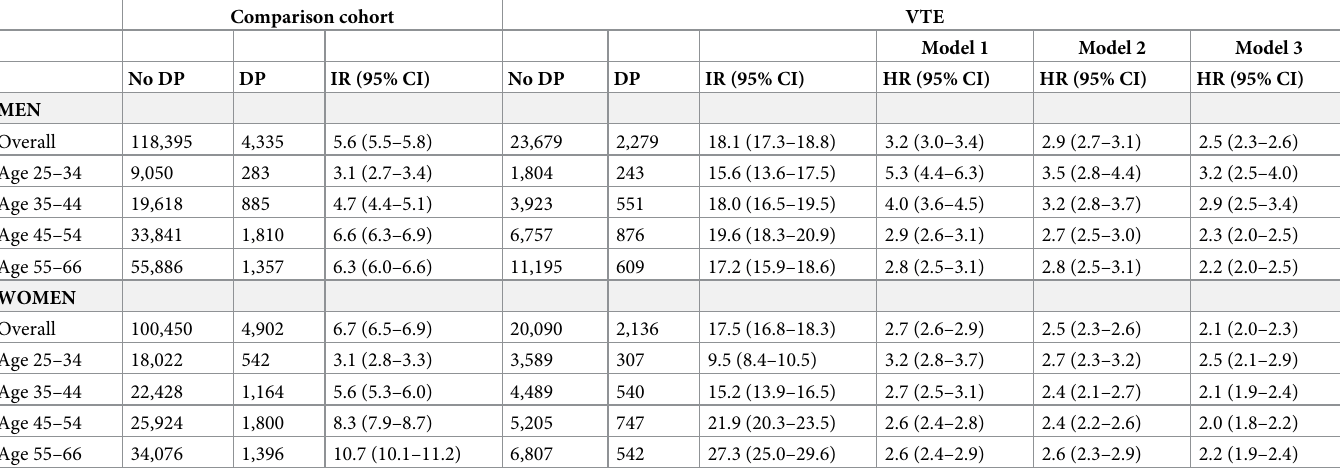
Table 3. IRs and HRs with 95% CIs by sex and age of receipt of a work-related DP for persons with and without VTE. Comparison